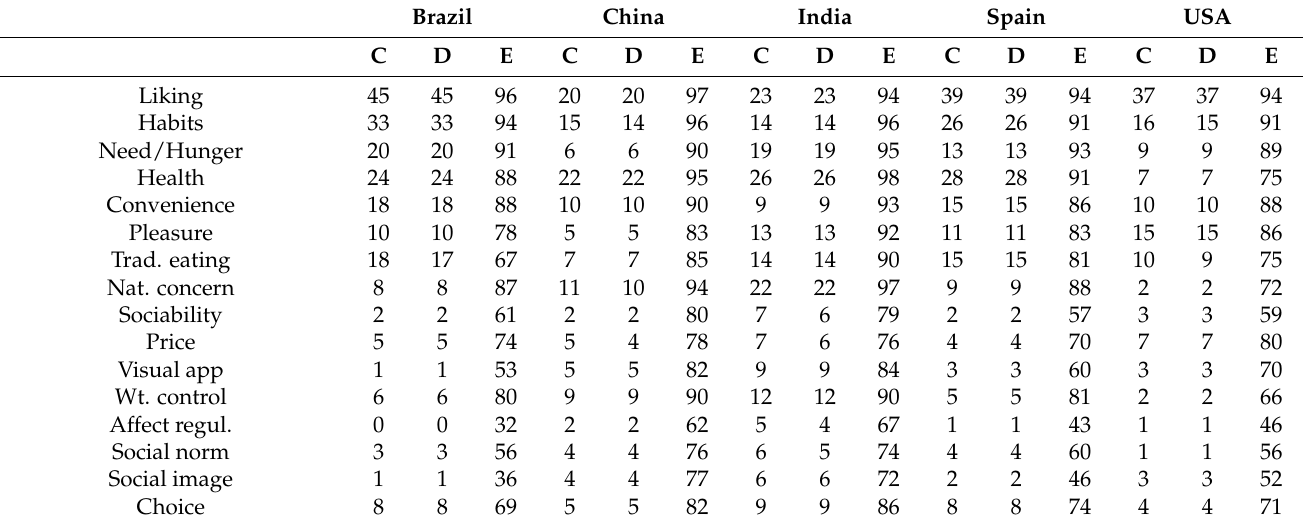
Table A2. Percentage of “apply” responses for CATA, RATA, and RATING for all five countries for the respective milk and dairy